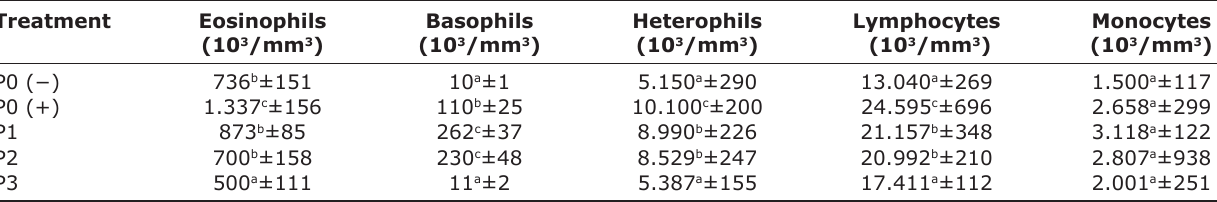
Table-2: The number of each type of leukocytes in broiler chickens infected with M. gallisepticum bacteria after the treatment